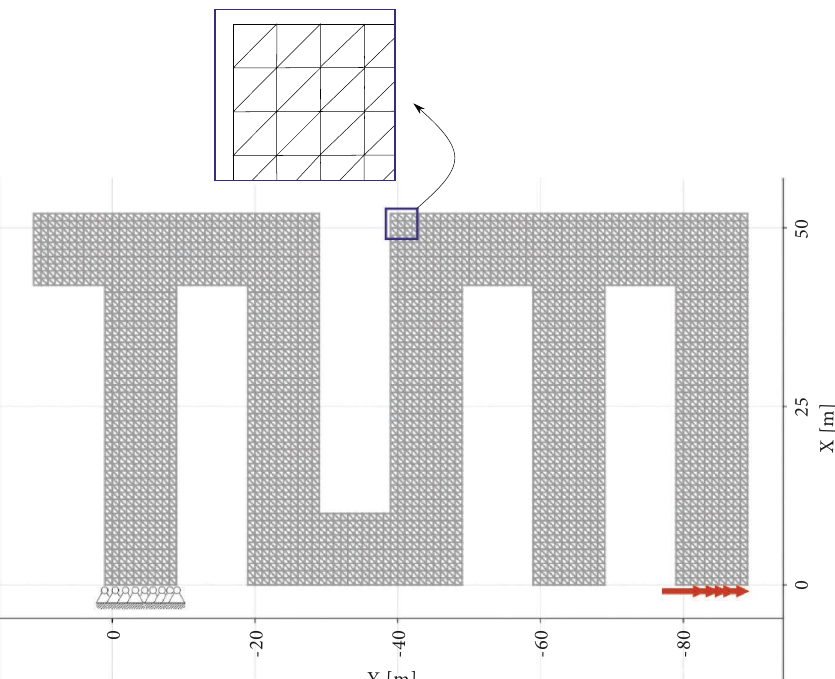
Figure 23: Known aim confguration. Te whole model consists of single nonlinear truss elements, as depicted in the blue box. As all displacements out-of-plane are constrained, a total number of 3241 nodes yield ≈ 7 e 3